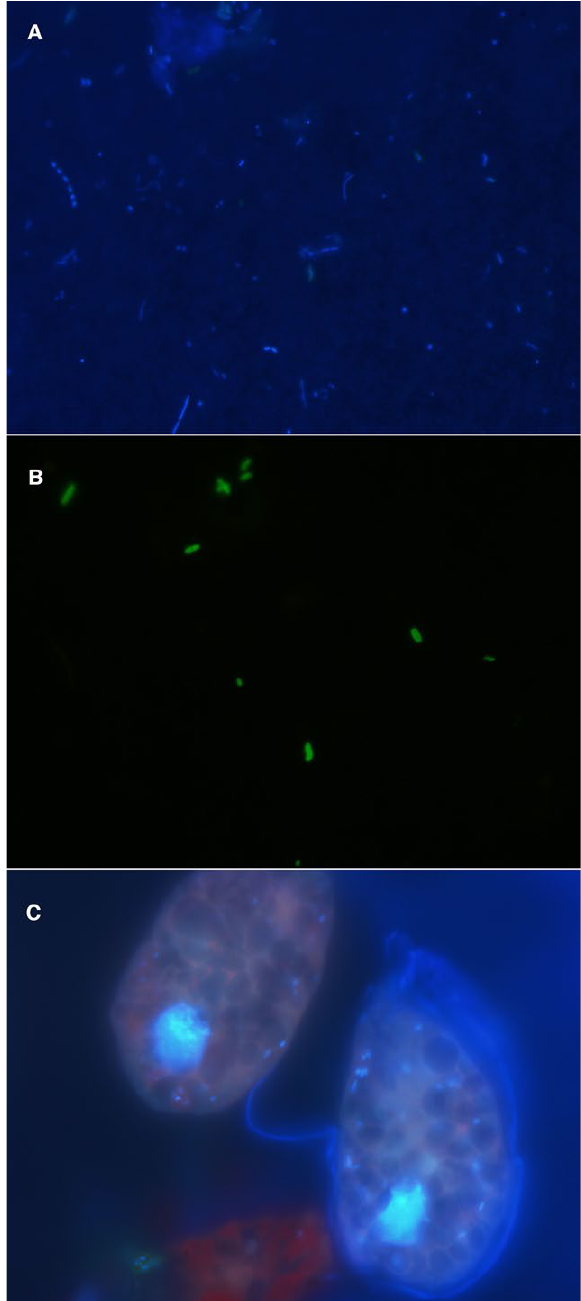
Fig. 3. – Epifluorescence microscopy of planktonic bacteria stained with DAPI (A), hybridized with the Vibrio CARD-FISH probe after amplification with tyramide-Alexa488 (B) and stained with DAPI and attached to an Ostreopsis cell